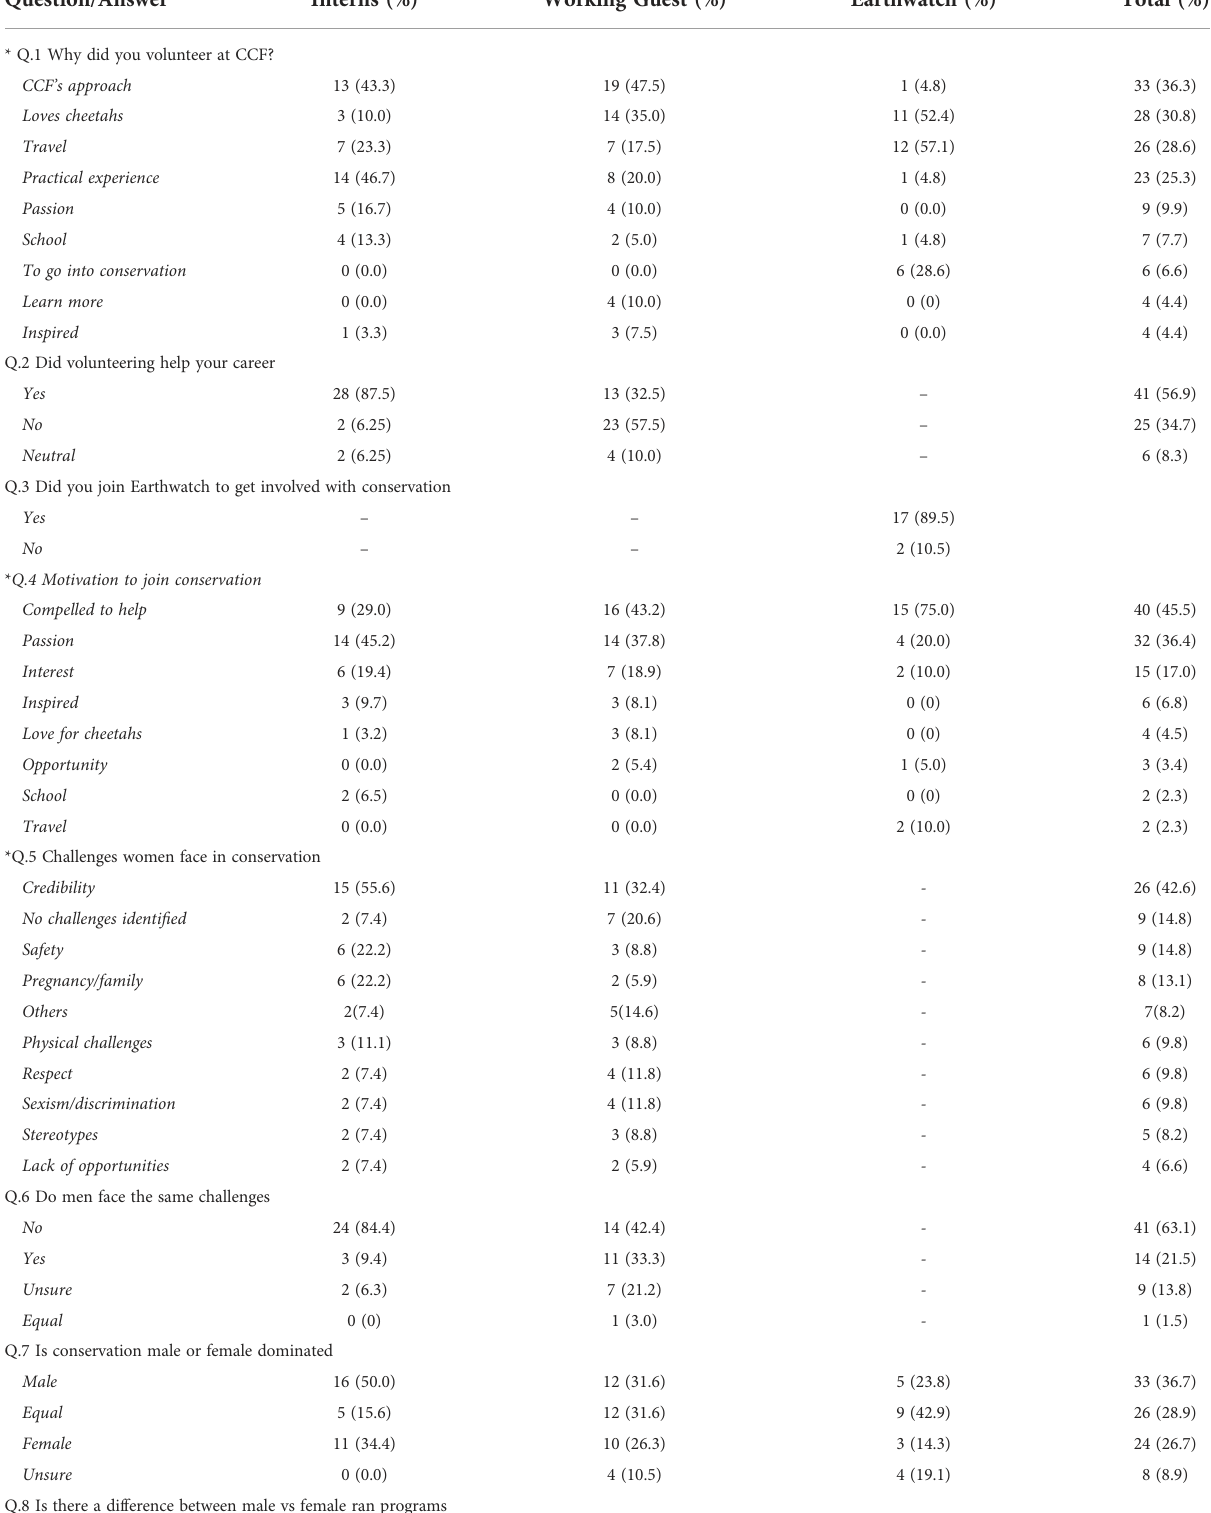
TABLE 3 Female responses to survey questions relating to volunteering and women in conservation, for three different types of volunteer experience.